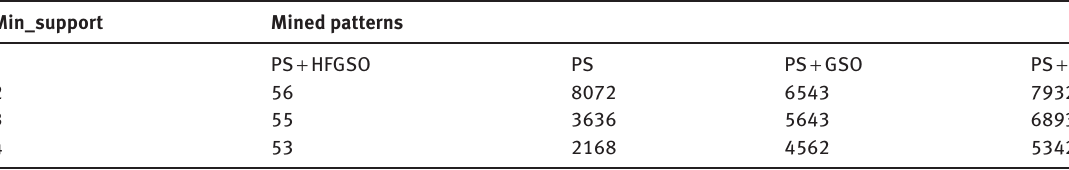
Table 8: Comparative Analysis of the Proposed Approach for Dataset 2.